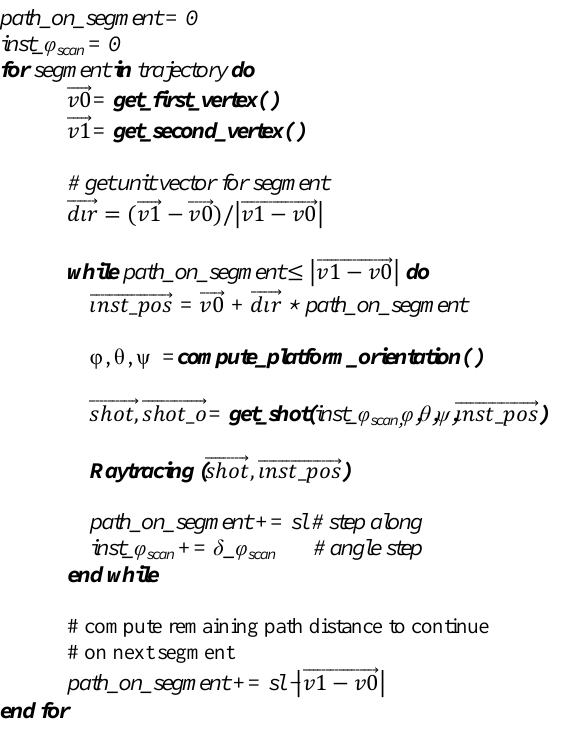
Algorithm 1. Pseudo code of motion simulation